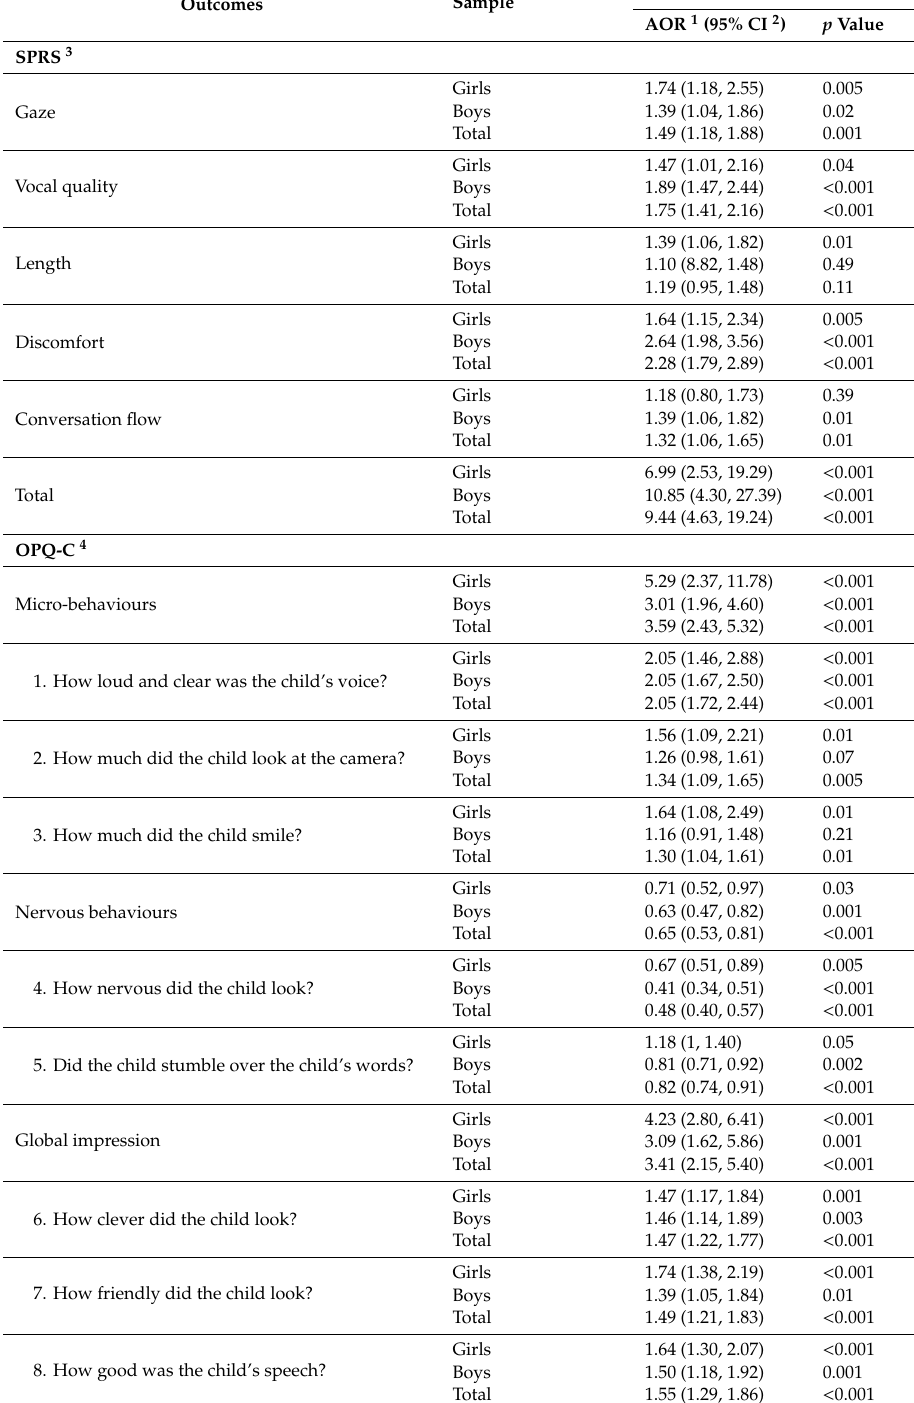
Table 3. Generalised linear models and e ff ect size estimates for the intervention e ff ect on the speech-task outcomes in the post-test (compared to the baseline) by